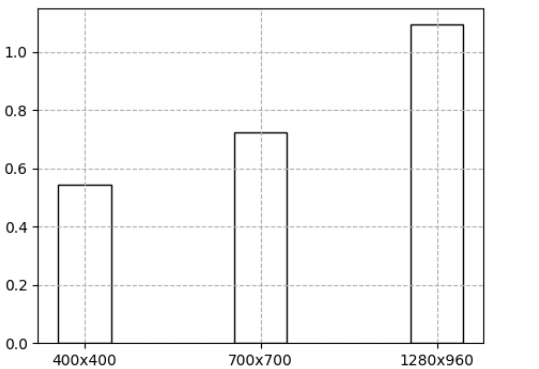
Figure 22. Average image processing time (s) vs. frame image size in